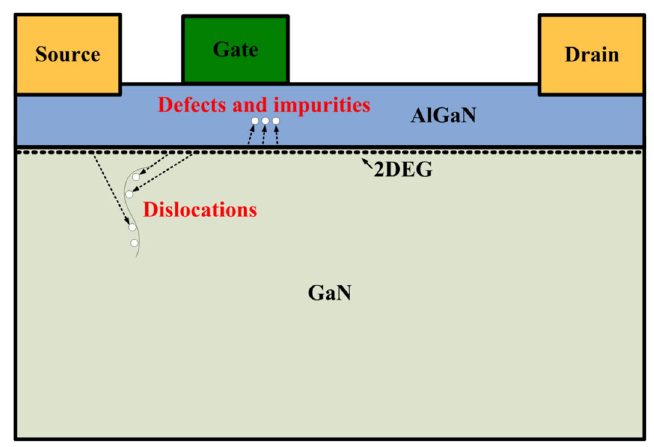
Figure 7. Schematic drawing of trapping in GaN HEMT induced by the microwave